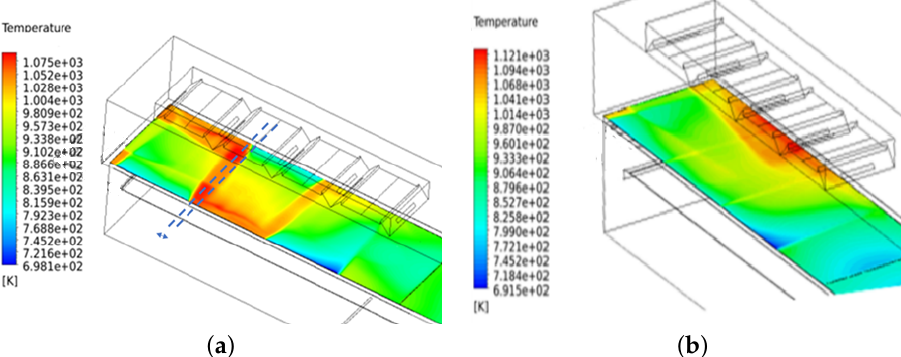
Figure 16. Iso-contours of window surface temperature for: ( a ) one-sided cooling Scheme A; and ( b ) alternated cooling Scheme C.